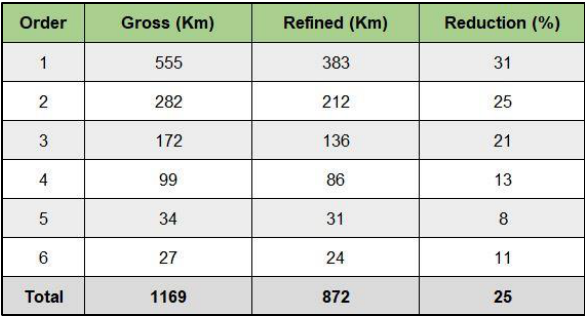
Table 2: Length of channels per Strahler order of streams before (gross) and after (refined) refinement, and overall reduction after refinement of the drainage